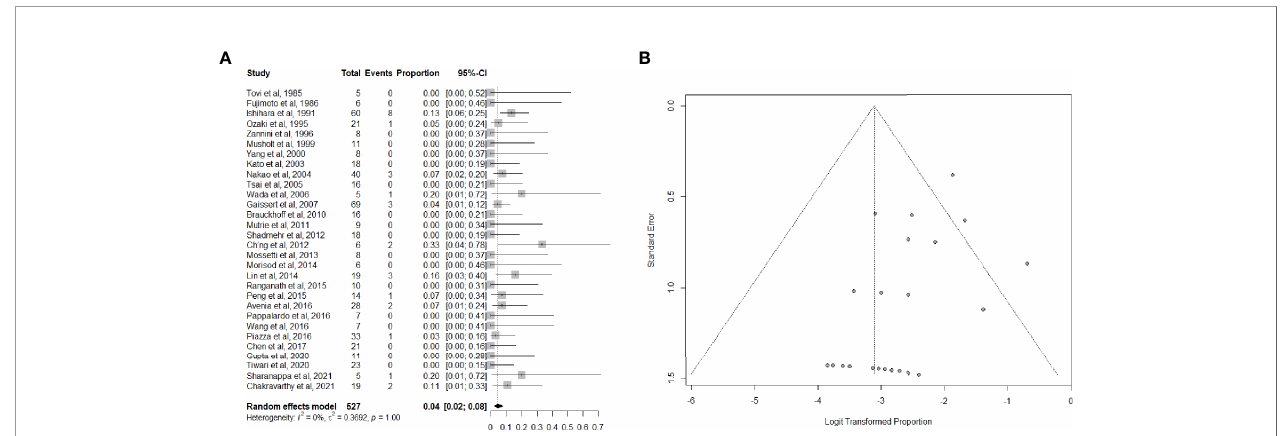
FIGURE 4 | (A) Forest plot showing the pooled analysis of tracheotomy-dependency and (B) relative funnel